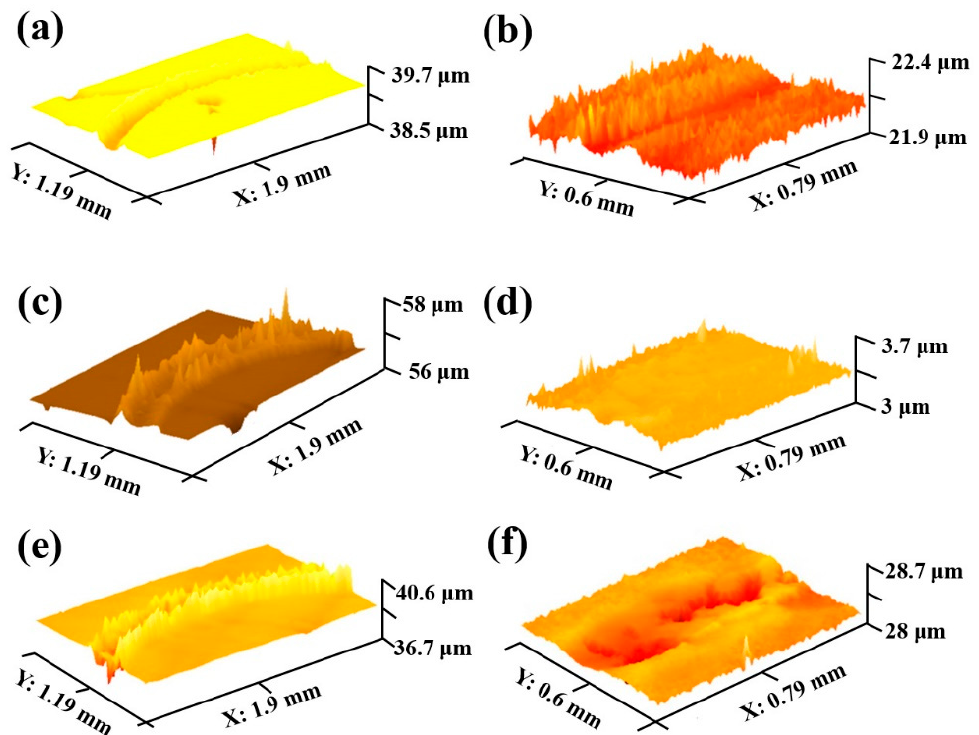
Figure 7. Three-dimensional morphology of substrate and borocarburized layer at different speeds ( a ) substrate under 50.083 m·s − 1 speed, ( b ) borocarburized layer under 0.083 m·s − 1 speed, ( c ) substrate under 0.167 m·s − 1 speed, ( d ) borocarburized layer under 0.167 m·s − 1 speed, ( e ) substrate under 0.333 m·s − 1 speed, ( f ) borocarburized layer under 0.333 m·s − 1 speed. Sliding wear results of the substrate and borocarburized layer at di ff erent speeds are shown